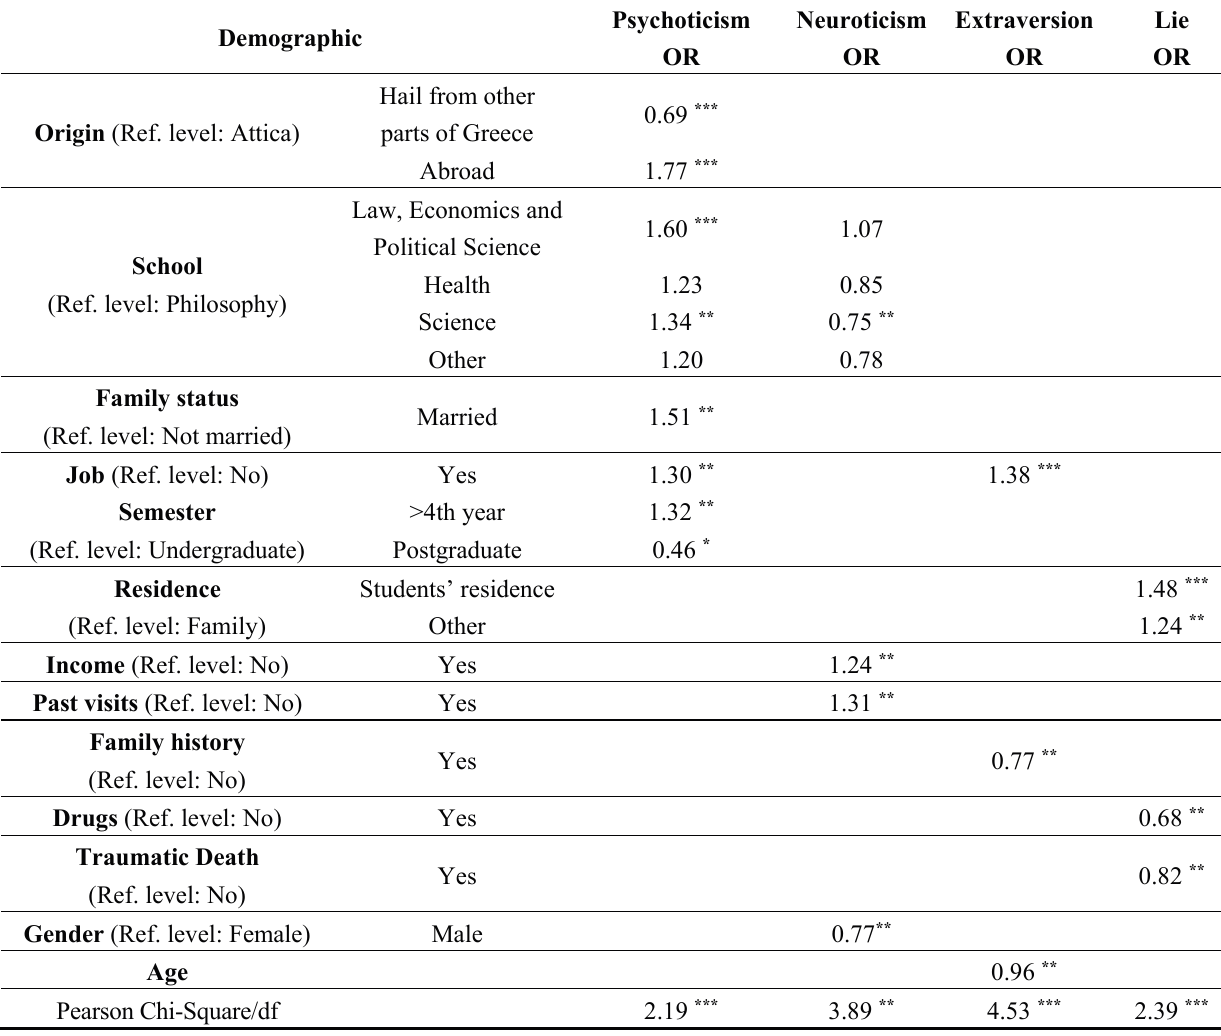
Table 6. Binomial generalized lineal models for each subscale of Eysenck Personality Questionnaire (EPQ).